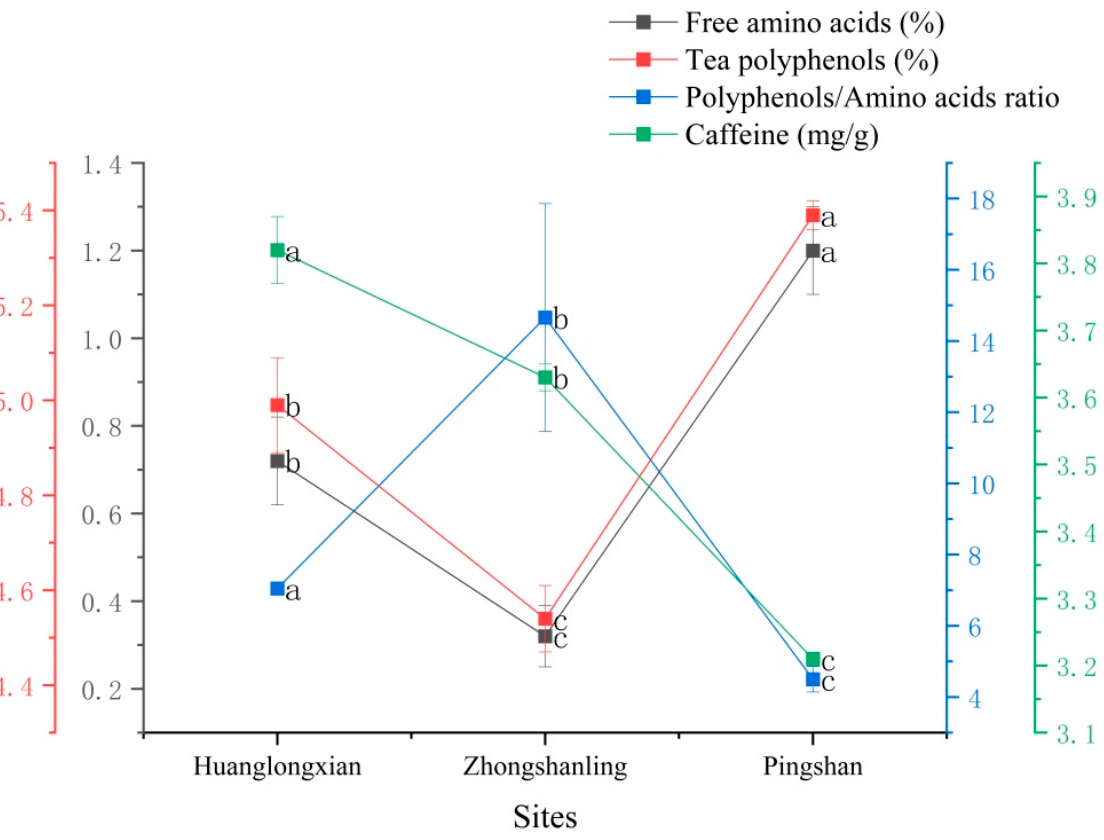
Figure 1. Chemical components in tea leaves in the three sampling sites. The significant variations are shown by different letters at the 0.05 level.3.3. Relationship between Tea Leaves Compositions and Soil Properties.